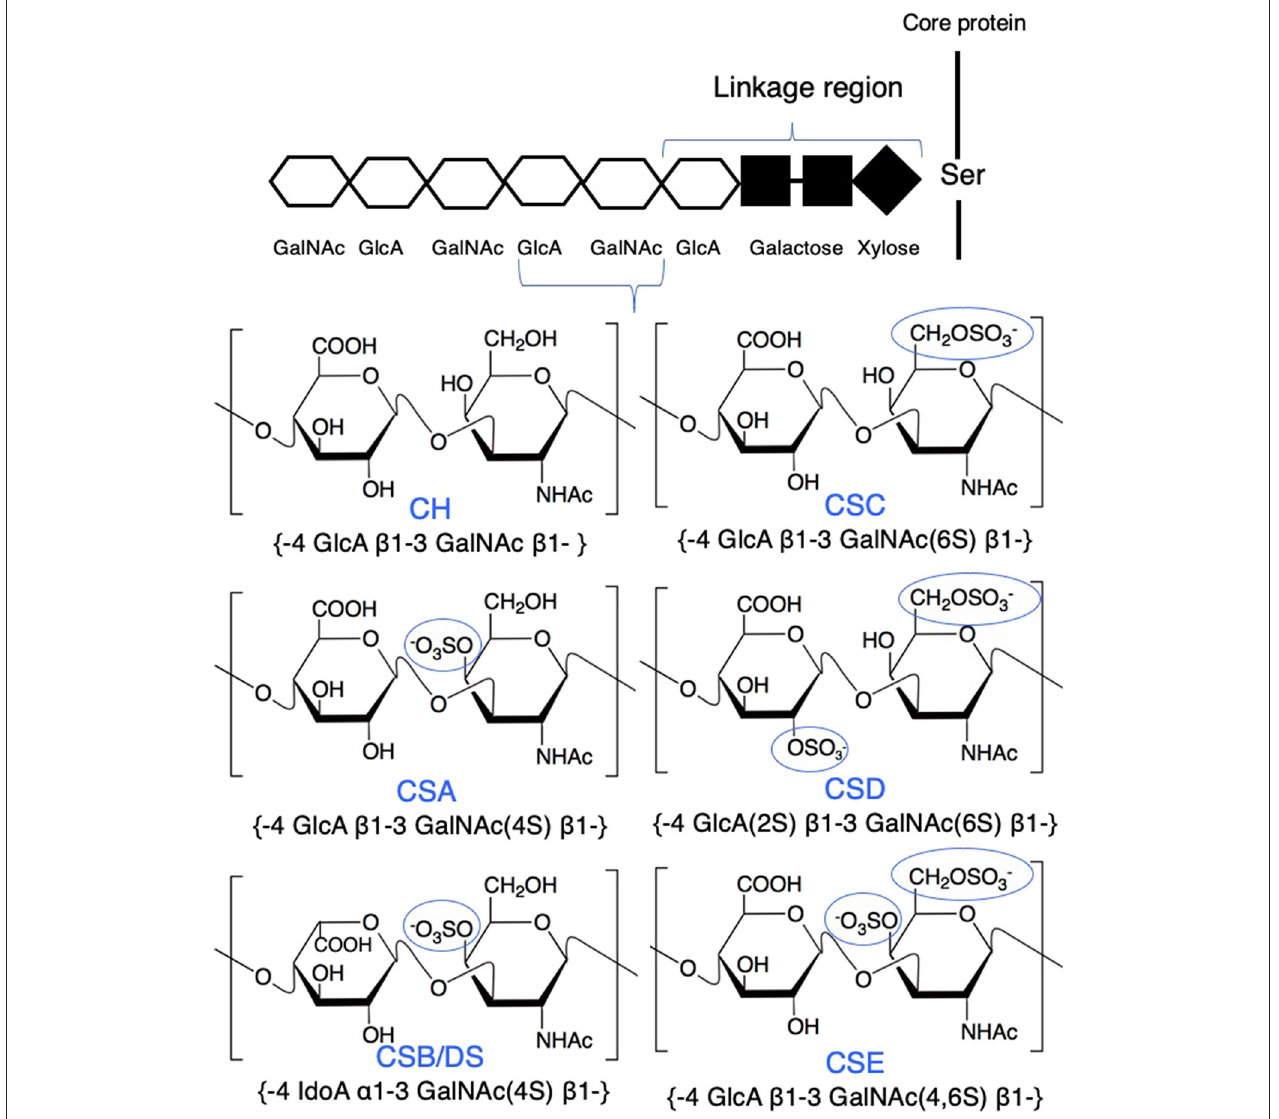
FIGURE 1 | Structure of major chondroitin sulfate (CS) disaccharides. CS is linked to a serine residue of a core protein via a linkage region. Repeating disaccharides form a linear polysaccharide chain, which is modified with sulfate groups at varying positions on sugar residues. The major disaccharide structures of CS are as follows: a non-sulfated unit (CH, GlcA-GalNAc); a monosulfated unit at the C-4 position of the GalNAc residue (CSA, GlcA-GalNAc4S); a monosulfated unit at the C-6 position of the GalNAc residue (CSC, GlcA-GalNAc6S); a disulfated unit at the C-2 position of GlcA and the C-6 position of the GalNAc residue (CSD, GlcA2S-GalNAc6S); and a disulfated unit at the C-4 and the C-6 positions of the GalNAc residue (CSE, GlcA-GalNAc4S6S). Certain GlcA residues are epimerized to IdoA (CSB or DS, IdoA-GalNAc4S).